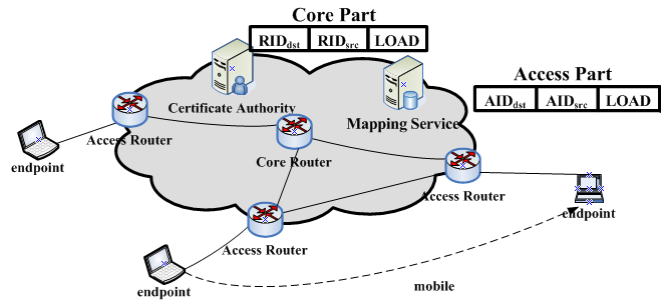
Figure 1. Universal Network (UN): A kind of ID/Locator separation network.